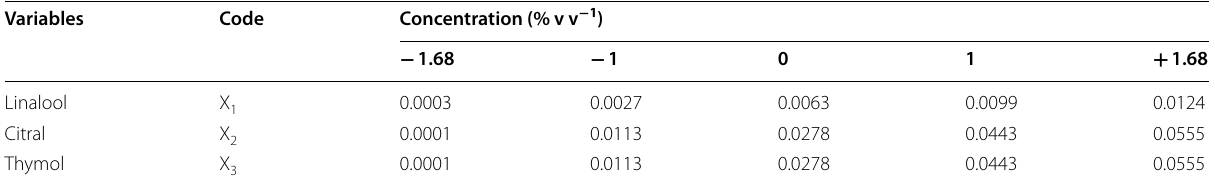
Table 2 CCRD matrix with coded and real values of the major components for evaluation of the S. flexneri growth as planktonic cells (PC)